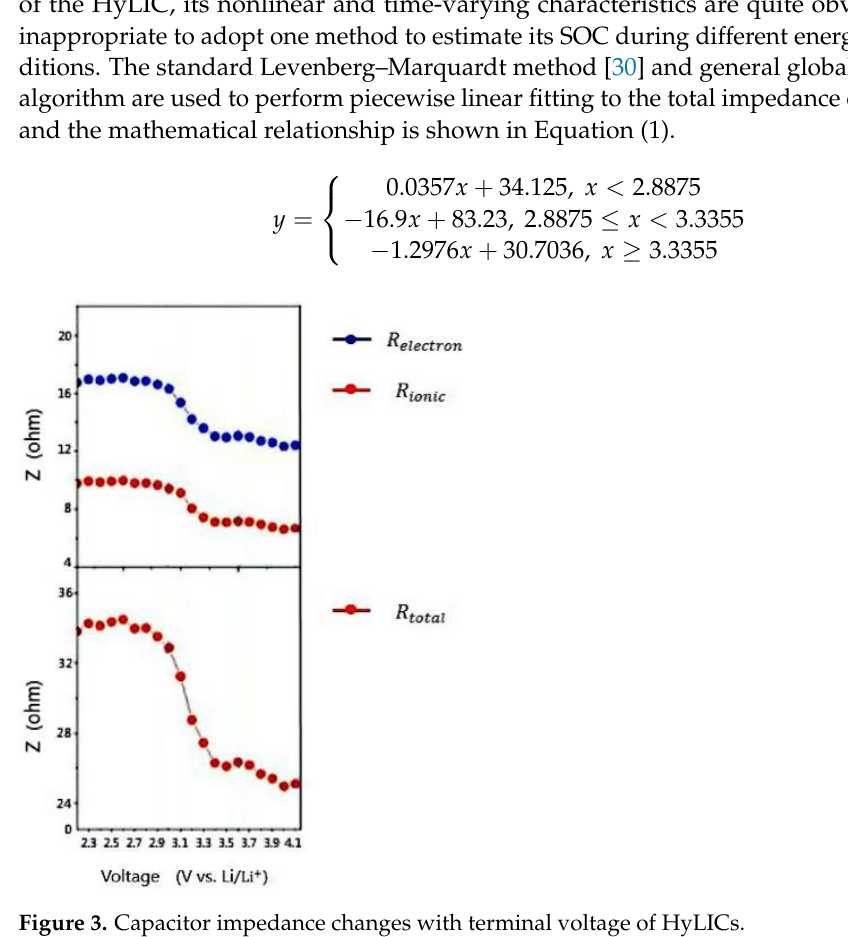
Figure 3. Capacitor impedance changes with terminal voltage of HyLICs. After fitting, the mean square error MSE = 0.3025, the residual sum of squares RSS = 1.8308 and the correlation coefficient R = 0.9969 indicate that the model fits the data well. Intervals are separated by blue and green dotted lines in Figure 4. When the HyLICs voltage is between 2.2 V and 2.90 V, the corresponding SOC interval is 3–20%, the slope of the discharge OCV–SOC curve is large, and the OCV of the HyLICs changes drastically with the SOC value. The total impedance curve remains basically stable. In this interval, the capacitive energy storage characteristics of HyLICs occupy a dominant position. When the terminal voltage rises to 2.90–3.35 V, the corresponding SOC range is 20–80%, with an obviously smaller slope of the discharge OCV–SOC curve. As the SOC value increases greatly, the OCV value changes less and the total impedance curve drops sharply in this interval. They all show that the energy storage characteristics of lithium batteries dominate in this interval of HyLICs. When the terminal voltage reaches 3.35–3.8 V, the corresponding SOC interval increases to 80–100%, the slope of the discharge OCV–SOC curve increases again, and the total impedance of the capacitor is reduced and becomes stable. The above results prove that the capacitive energy-storage characteristic of HyLICs takes control